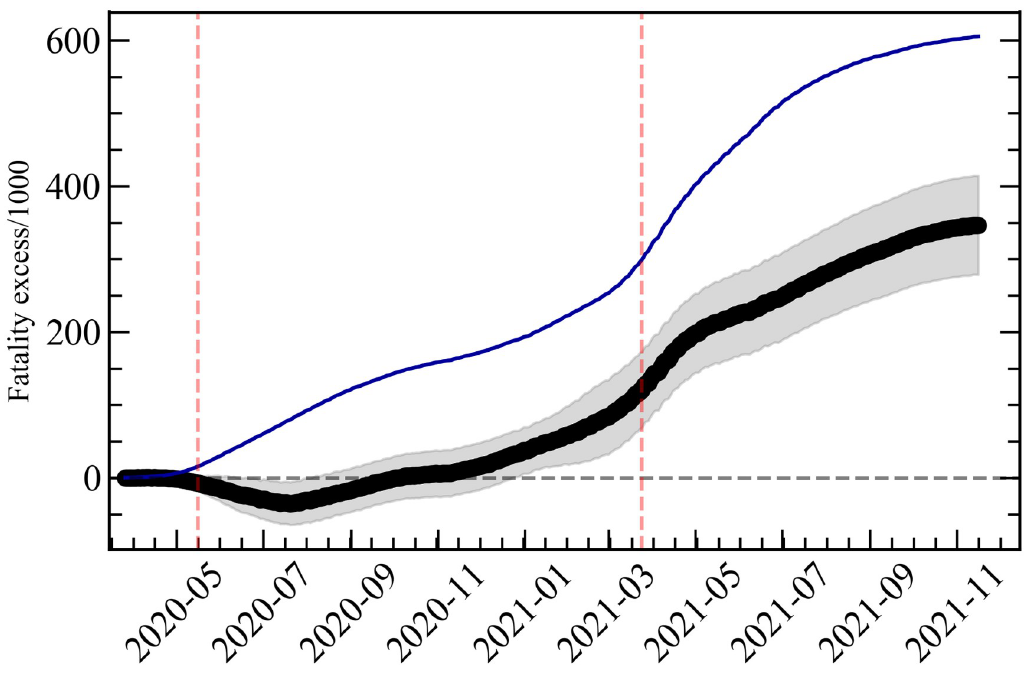
Fig 4. Evolution in time of the total number of deaths in Brazil due to COVID-19 (dark blue line) and of the excess of fatality in Brazil due to the political influence of President Bolsonaro (black line). Error bars of the black curve are given by the gray region. The vertical dashed lines are the same as for Fig